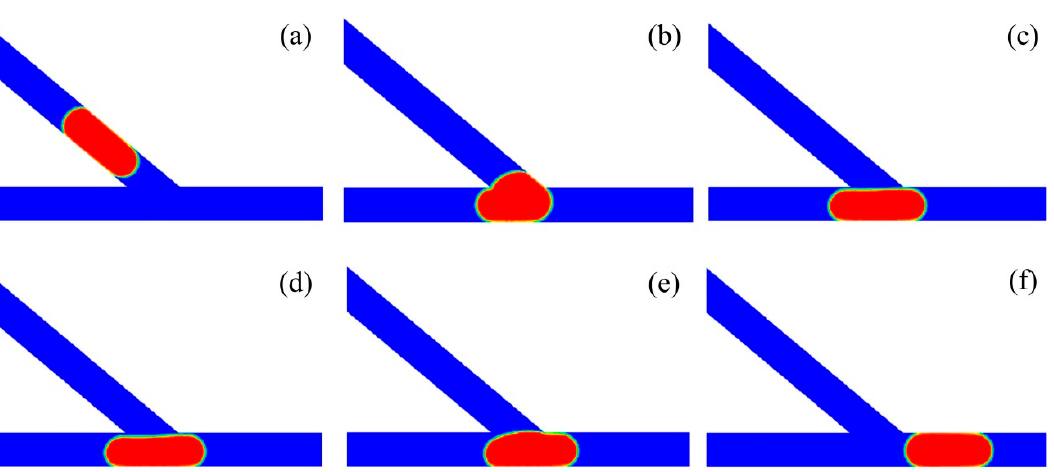
Figure 10. Passive sorting of droplet into the right channel at the relatively small velocity of U = 4 mm/s ( θ = 40°, V d / w 3 = 2). ( a ) T0, ( b ) T1 = T0 + 2.56, ( c ) T2 = T0 + 3.52, ( d ) T3 = T0 + 4, ( e ) T4 = T0 + 4.48, ( f ) T5 = T0 + 8.